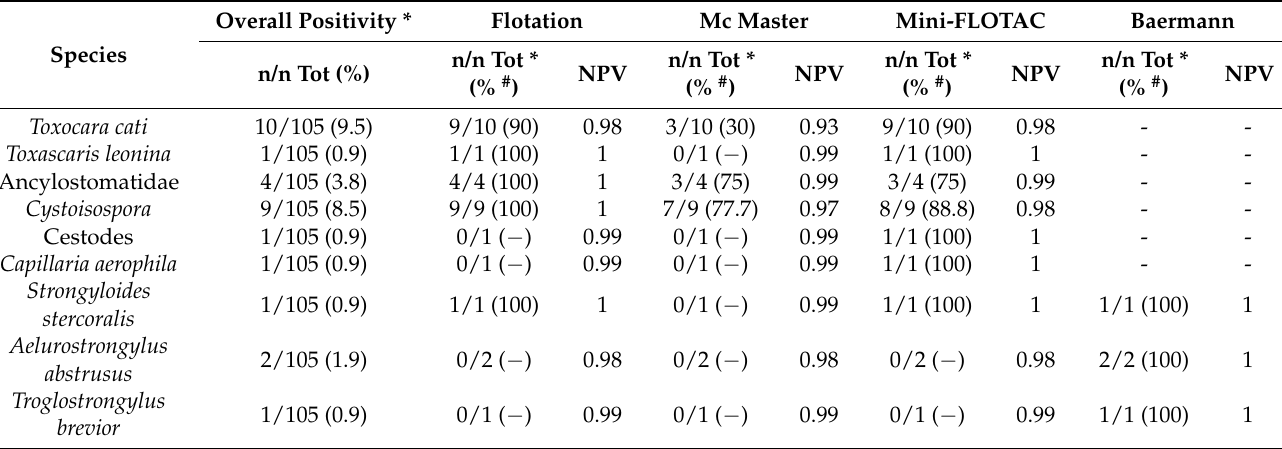
* Regardless of the copromicroscopic technique used; # sensitivity; NPV: Negative predictive value.